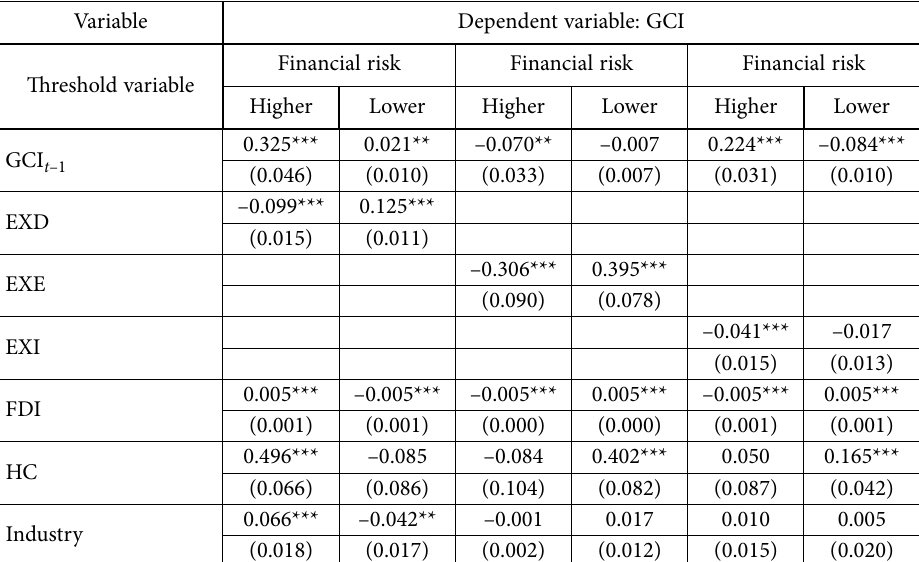
Table 8. DPT estimations for GCI (threshold =